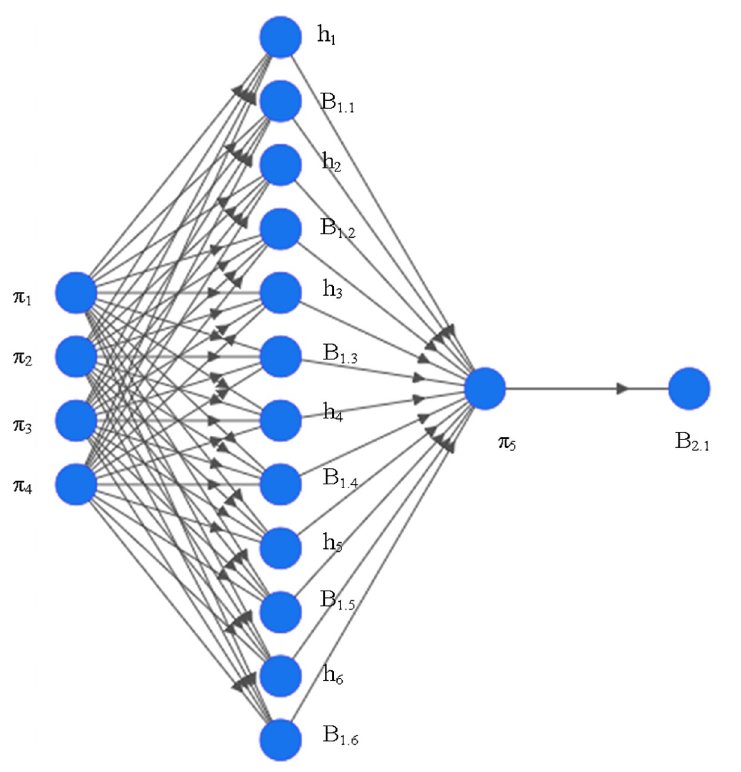
Fig 1. Dimensionless parameters-BP neural network model